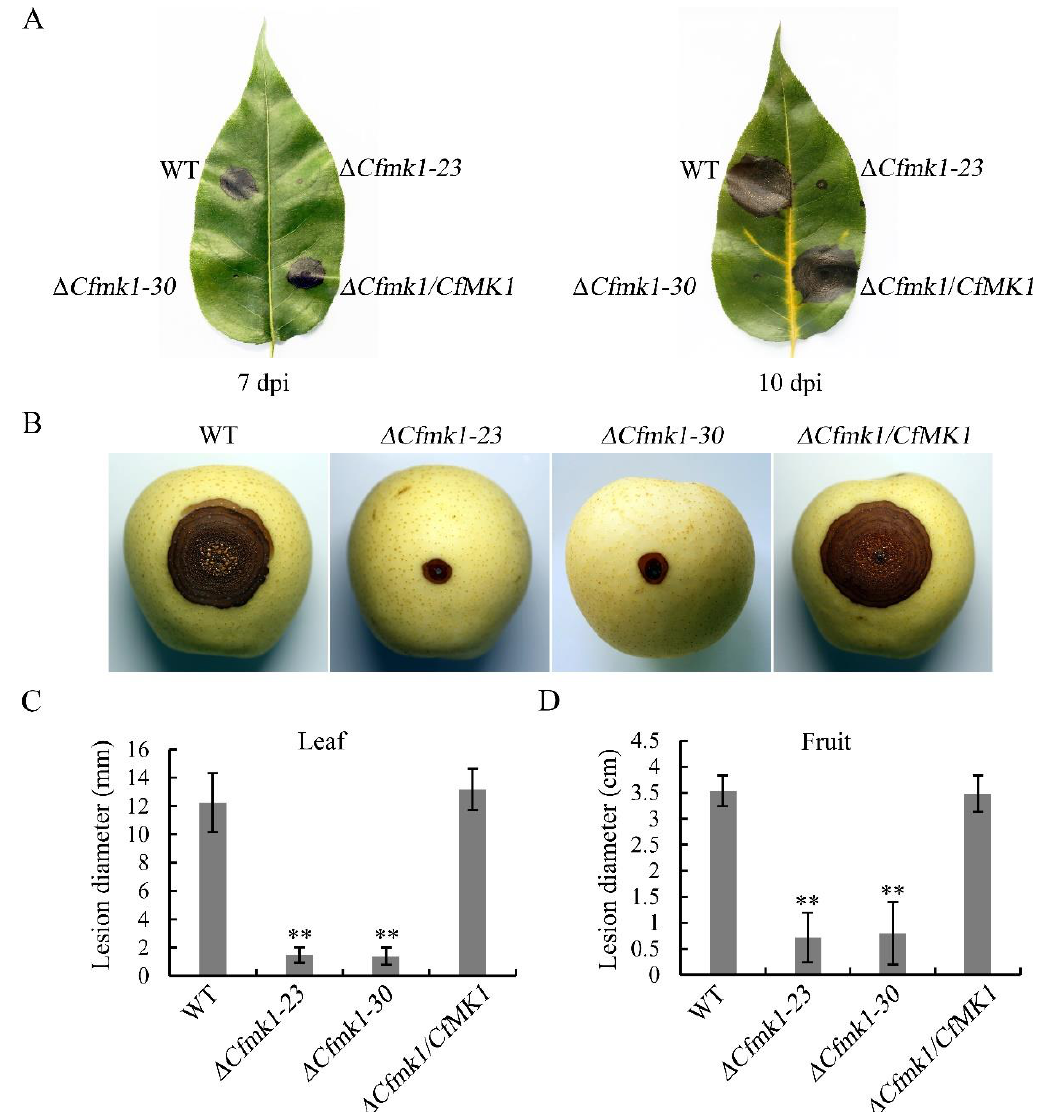
Figure 6. Pathogenicity assay on pear leaves and fruit. ( A ) Detached pear leaves were inoculated with conidial suspensions of the WT, Δ Cfmk1-23 , Δ Cfmk1-30 , and Cfmk1 / CfMK1 . Typical leaves were photographed 7 and 10 dpi. ( B ) The same set of conidial suspensions was inoculated into the wounded fruit. Diseased fruit were photographed at 5 dpi. ( C ) Lesion diameter of anthracnose on leaves. ( D ) Lesion diameter of anthracnose in fruit. Vertical bars represent standard deviations of the means. Asterisks indicate significant differences in the values at p ≤ 0.01 (**).